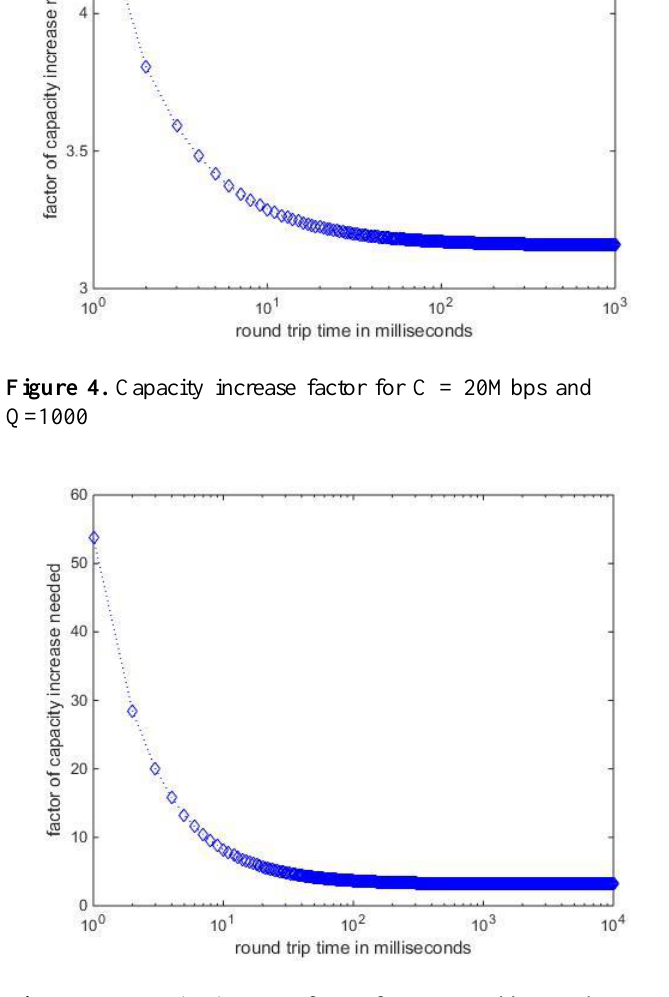
Figure 5. Capacity increase factor for C = 512kbps and